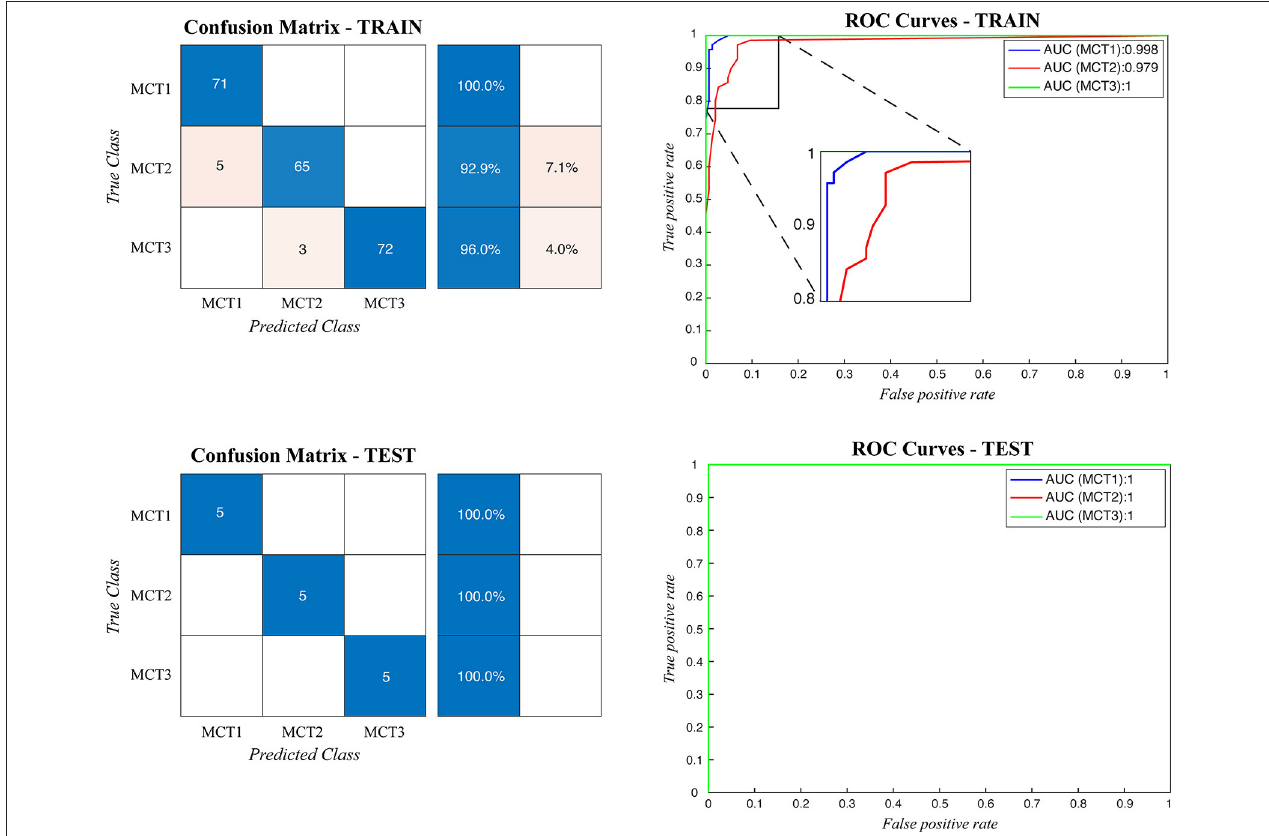
FIGURE 5 | Confusion matrix and the ROC curves obtained during mast cell tumors grading for both train and test datasets. MCT1: grade 1, MCT2: grade 2, MCT3: grade